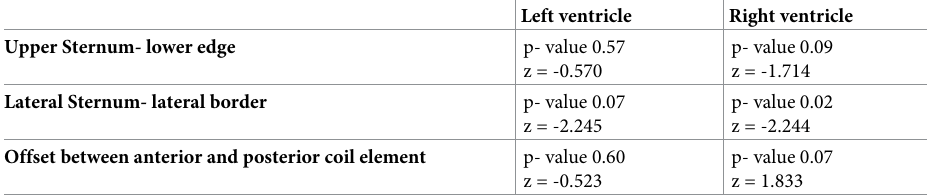
Table 2. Kendall’s rank correlation of the coil position with the image quality of the left and right ventricle.